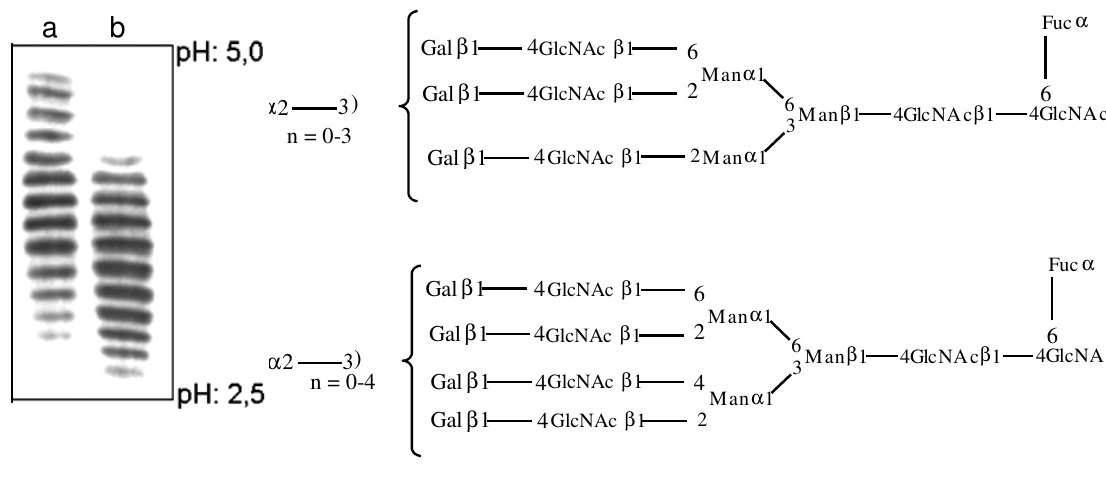
FIGURE 1. Differences between rHu-EPO and Neuro-EPO by isoelectric focusing method. Most abundant N-glycans covalenty linked to EPO molecule (AS): sialic acid. (a) Neuro-EPO: sialic acid content is 4–7 mol/mol protein. (b) rHu-EPO: sialic acid content is 10–12 mol/mol